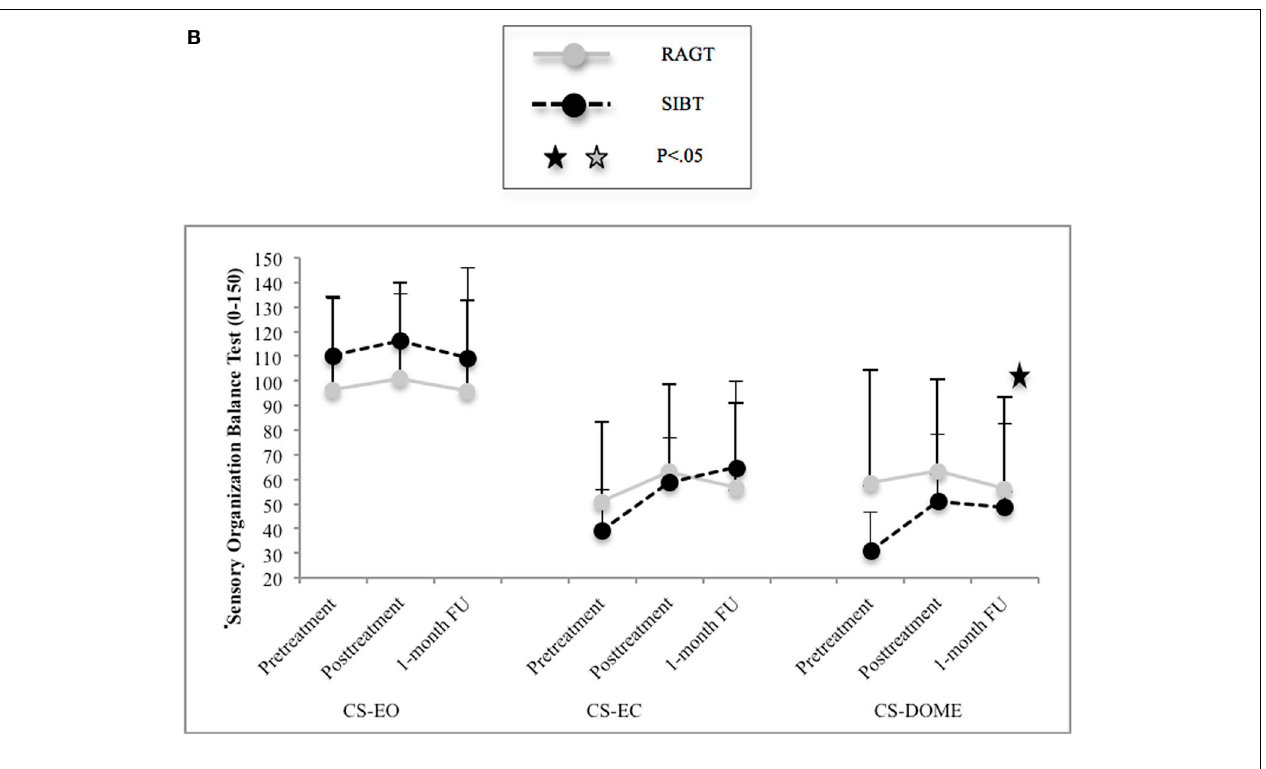
FIGURE 2 | (A) Within group analysis: mean performance and standard errors at primary and statistical significant secondary outcome measures. Abbreviations: SS, stable surface; CS, complaint surface; EO, eyes-open condition; Dome, Dome condition; FU, follow-up. (B) Between group